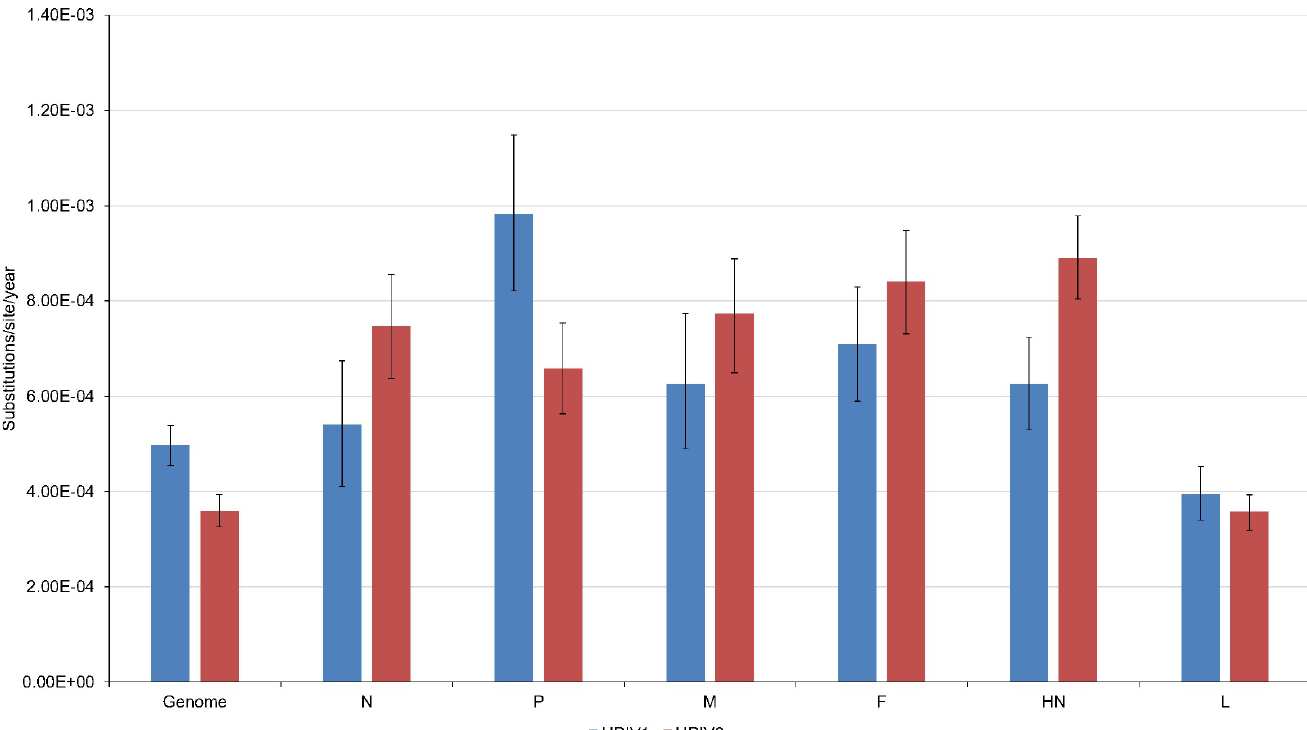
Fig 2. Evolutionary rates for each coding sequence in HPIV-1 and HPIV-3. Error bars represent the 95% highest posterior density.